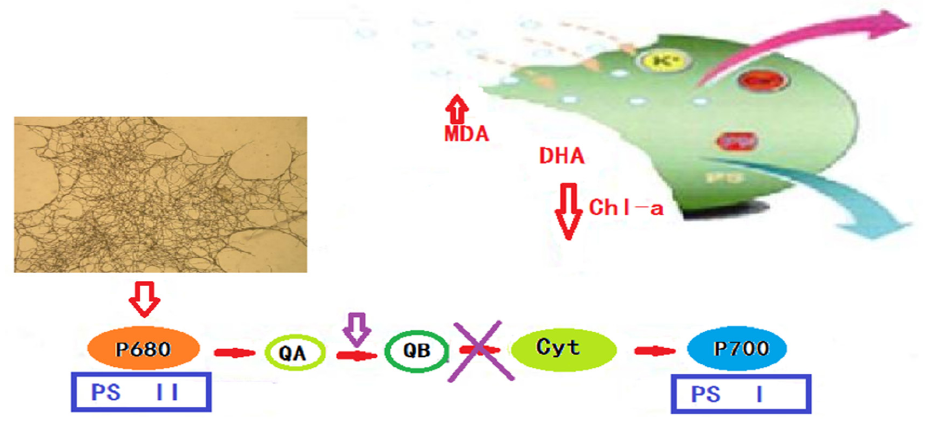
Figure 8. The algae lysis mechanism of white rot